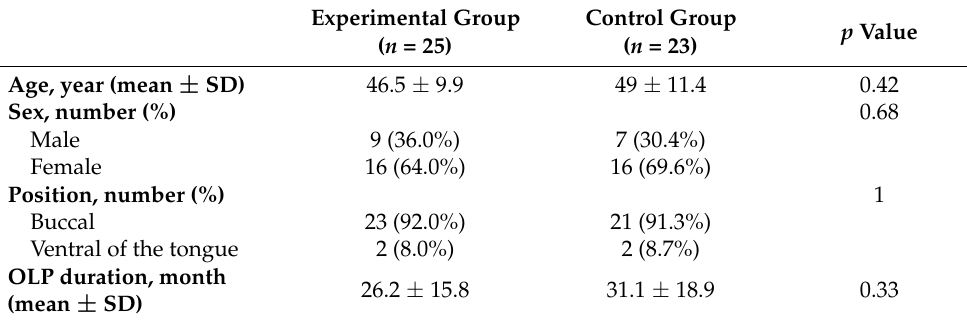
Table 1. Baseline demographic